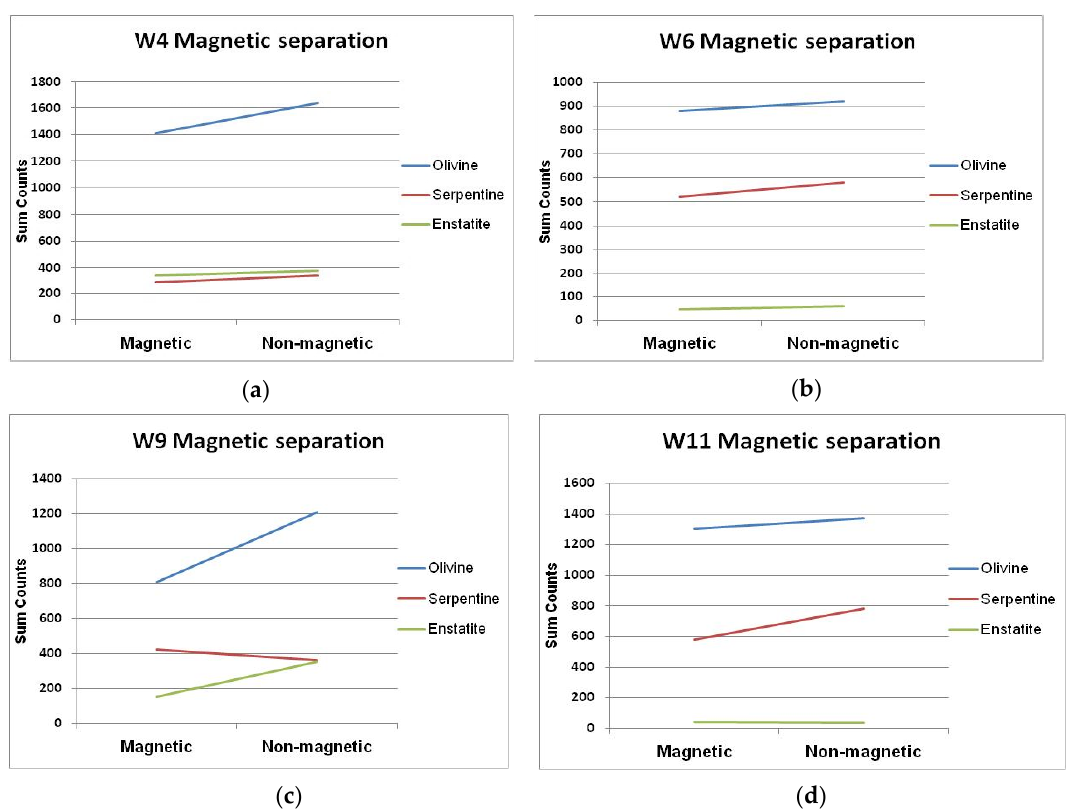
Figure 2. Diagrams of main diffraction peak count variations in the XRD patterns for the samples: